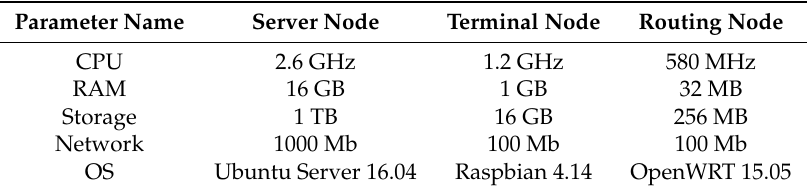
Table 1. Specifications of